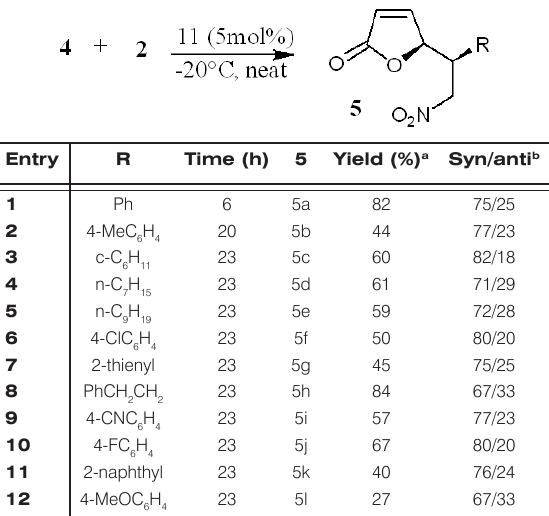
Table 3. Conjugate addition of 6 to nitroalkene 2 catalyzed by Phosphoric acid 11 .